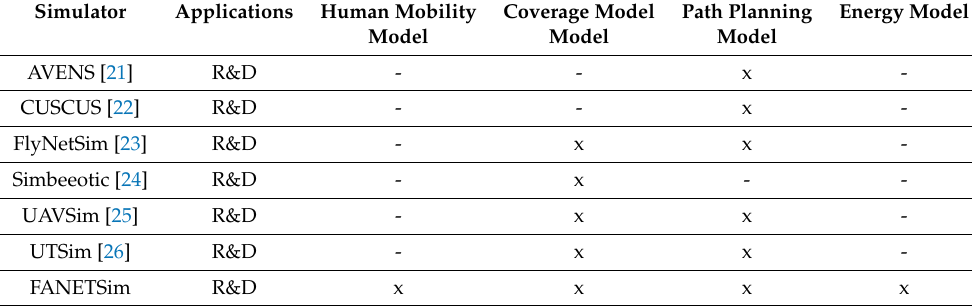
Table 2. Comparison of UAVs software simulators on implemented